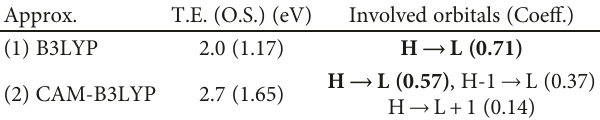
Table 5: Transition corresponding to λ maxTh for the CL1 dye within B3LYP and CAM-B3LYP: T.E.: transition energy (= λ maxTh ) in eV; O.S.: oscillator strength; and Coe ff .: the magnitude of the con fi guration interaction singles coe ffi cients. The most prominent transitions (indicated by the magnitude of the con fi guration interaction singles coe ffi cients) are highlighted in bold.